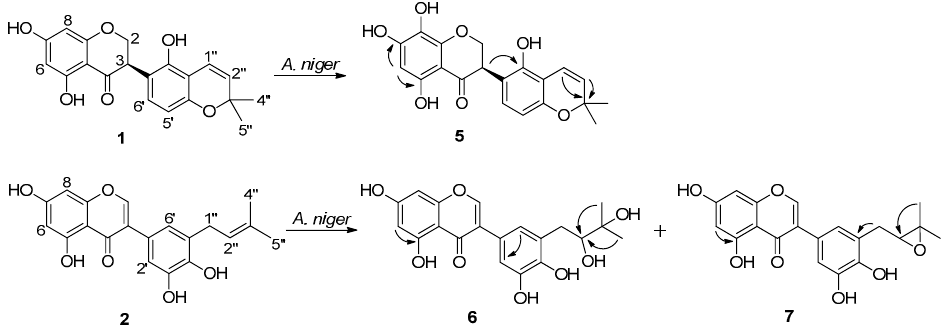
Figure 1. Compounds 5 – 7 obtained by biotransformation of 1 and 2 with A. niger . Selected HMBC correlations ( 1 H → 13 C) of compounds 5 – 7 are indicated by arrows.